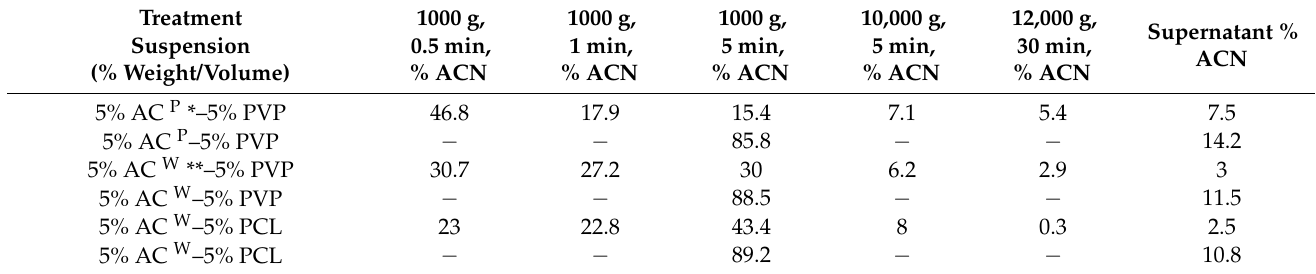
Table 2. Sedimentation of ACNs by centrifugation in different conditions.